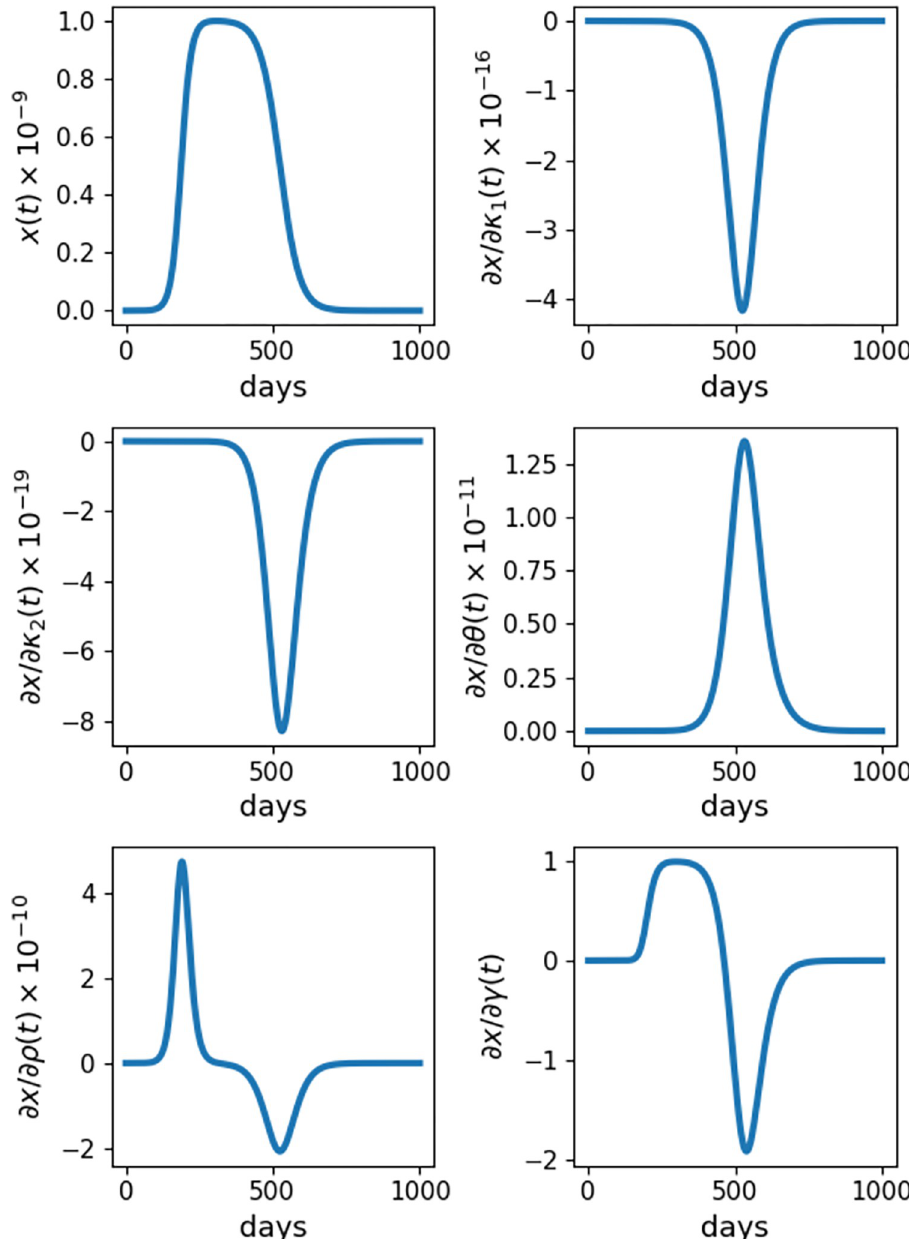
Fig 2. Sensitivity of Cancer Cells in the CARRGO Model. Time series plots of cancer cells ( x ( t )) and the derivatives of x ( t ) with respect to the CARRGO parameters κ 1 , κ 2 , θ , ρ , γ . Results shown are for the initial conditions and parameter values defined in Fig 1 and simulated over the course of t = 1000 days. The complex perturbation method of sensitivity analysis is used to compute derivatives. Our parameter choices roughly capture measurements for the COVID-19 virus from early in the pandemic [22,23]. Fig 3 plots the susceptible curve and its sensitivities. In this case all three curves conveniently occur on comparable scales. Fig 3 captures not only the pronounced parameter sensitivity early in the pandemic but also the symmetry between the δ and η parameters.